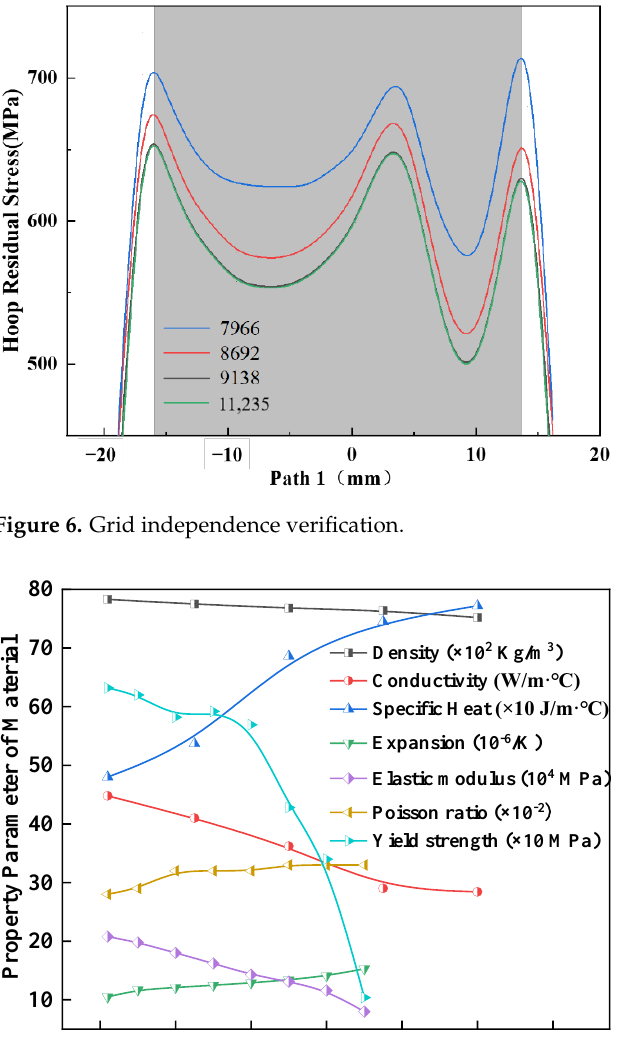
Figure 5. Finite element model.